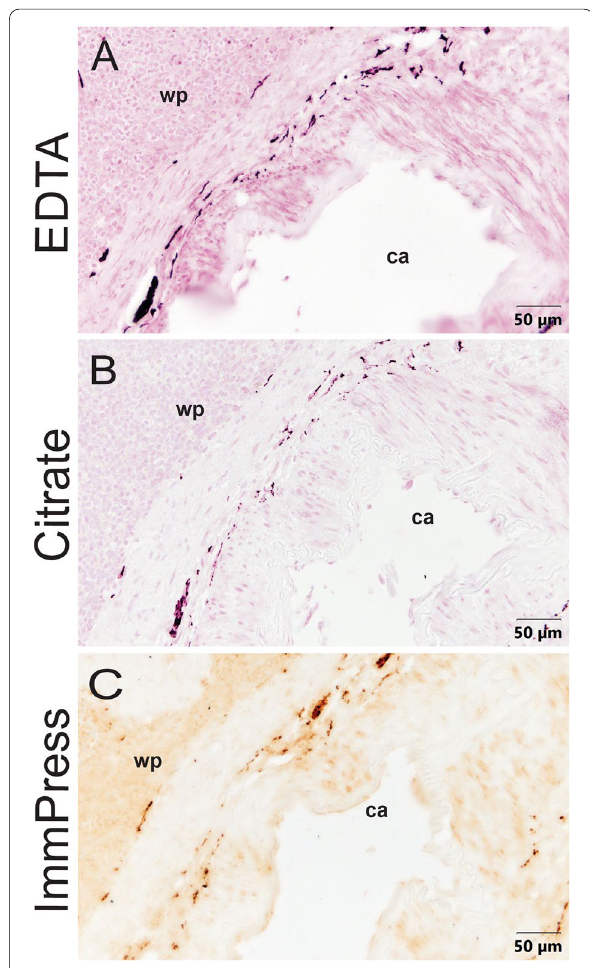
Fig. 1 Comparison of different IHC antigen retrieval buffers and chromogens used to stain spleen tissue. Images were taken from three consecutive sections of spleen from a 57-year-old male (donor 004) and stained for TH. Images show white pulp (wp) and a central artery (ca.). A VIP purple chromogen using EDTA antigen retrieval showed greater intensity of nerve staining as well as higher degree of tissue degradation. B VIP purple chromogen using citrate buffer antigen retrieval better preserved the adventitia of blood vessels when compared to EDTA antigen retrieval. Additionally, spleen sections stained for TH using citrate antigen retrieval yielded less background staining than the other two methods. C ImmPRESS DAB chromogen using citrate buffer antigen retrieval showed